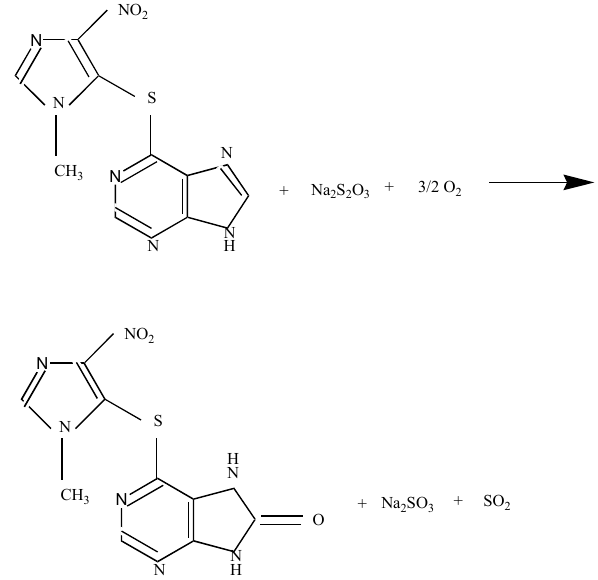
Scheme 1. Photochemical reaction of Na 2 S 2 O 3 -reacted